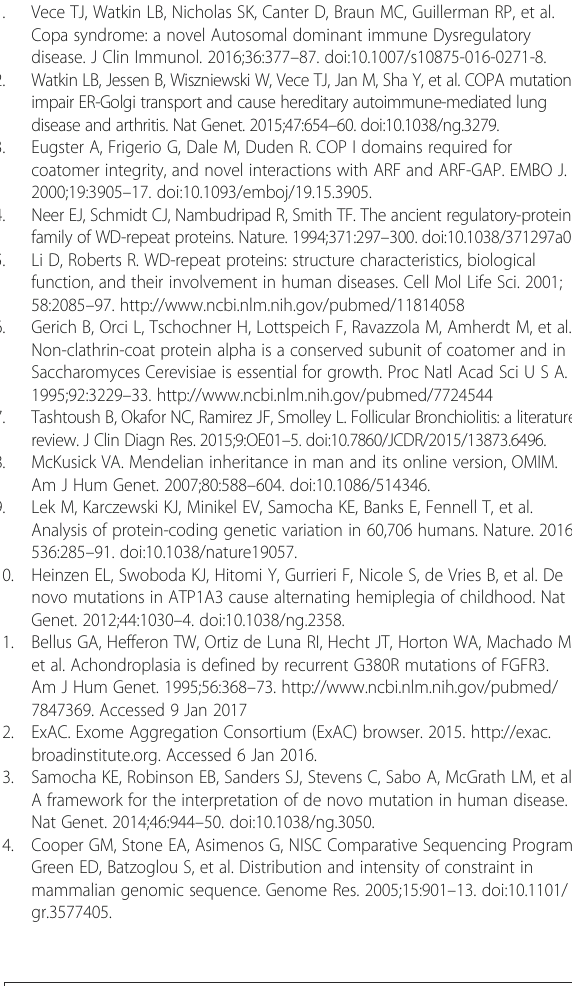
variant calling and annotation) and the genetic analysis performed in this study (Additional file 10: Table S5). (DOCX 23 kb) Additional file 7: Figure S4. Variant filtering flowchart. We detected an average of 4,942,809 coding and non-coding variants per affected member of the family. Sixteen variants with MAF <0.1% in the Icelandic population (MAF derived from 30,067 Icelandic genomes) were shared by the three affected. Out of the 16 variants, one was private to the affected family members. (DOCX 41 kb) Additional file 8: Table S3. COPA mutation. Summary of the causative mutation causing the lung disease in the Icelandic family. (DOCX 19 kb) Additional file 9: Table S4. Sequencing data metrics for the COPA mutation. The call ratios of the COPA mutation for the index case, affected son and daughter, and unaffected husband, mother, and father from the WGS data. Additionally, the Sanger sequencing genotypes for the three siblings of the index case are listed. (DOCX 13 kb) Additional file 10: Table S5. Coding variants with MAF < 0.1% in Iceland shared between all three affected family members. (DOCX 14